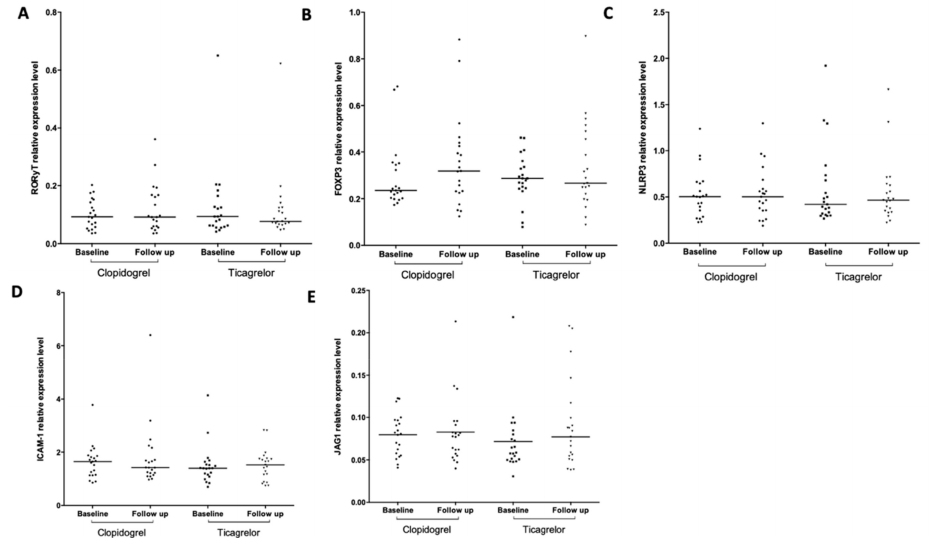
Figure 1. Droplet digital (dd) PCR based analysis of the expression of inflammation- and oxidative stress-related genes in peripheral blood cells of stable coronary artery disease (CAD) / concomitant chronic obstructive pulmonary disease (COPD) patients following 1-month treatment with ticagrelor and clopidogrel. Scatter plots, with medians, of the expression levels of ROR γ t ( A ), FoxP3 ( B ), NLRP3 ( C ), ICAM1 ( D ), and JAG1 ( E ) are shown. The absolute quantity of cDNA (copies / µ L) was normalized to the average number of copies of GUSB . Follow up vs. baseline gene expression values, ANOVA test. Comparison of gene expression levels at baseline, student t